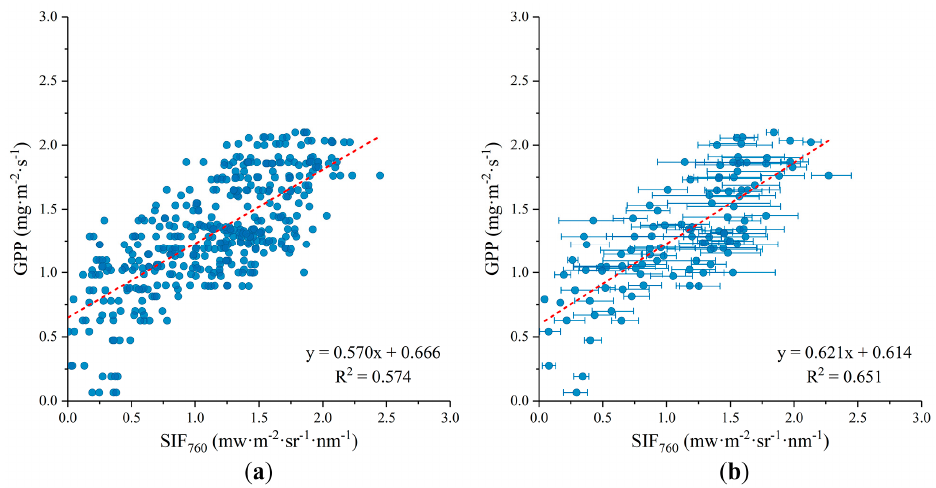
Figure 5. Relationship between: ( a ) individual SIF 760 and GPP; and ( b ) averaged SIF 760 and GPP. The error bars indicate the range of SIF 760 values for the four measurements.